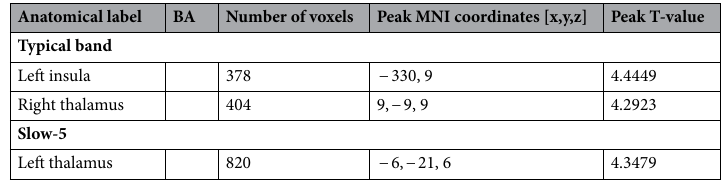
Table 2. Comparisons of Regional Homogeneity between groups in typical low frequency range (0.01– 0.08 Hz) and slow-5 frequency bands (GRF Corrected, Overall P < 0.05). All the coordinates are denoted by Montreal Neurological Institute (MNI) space coordinates.